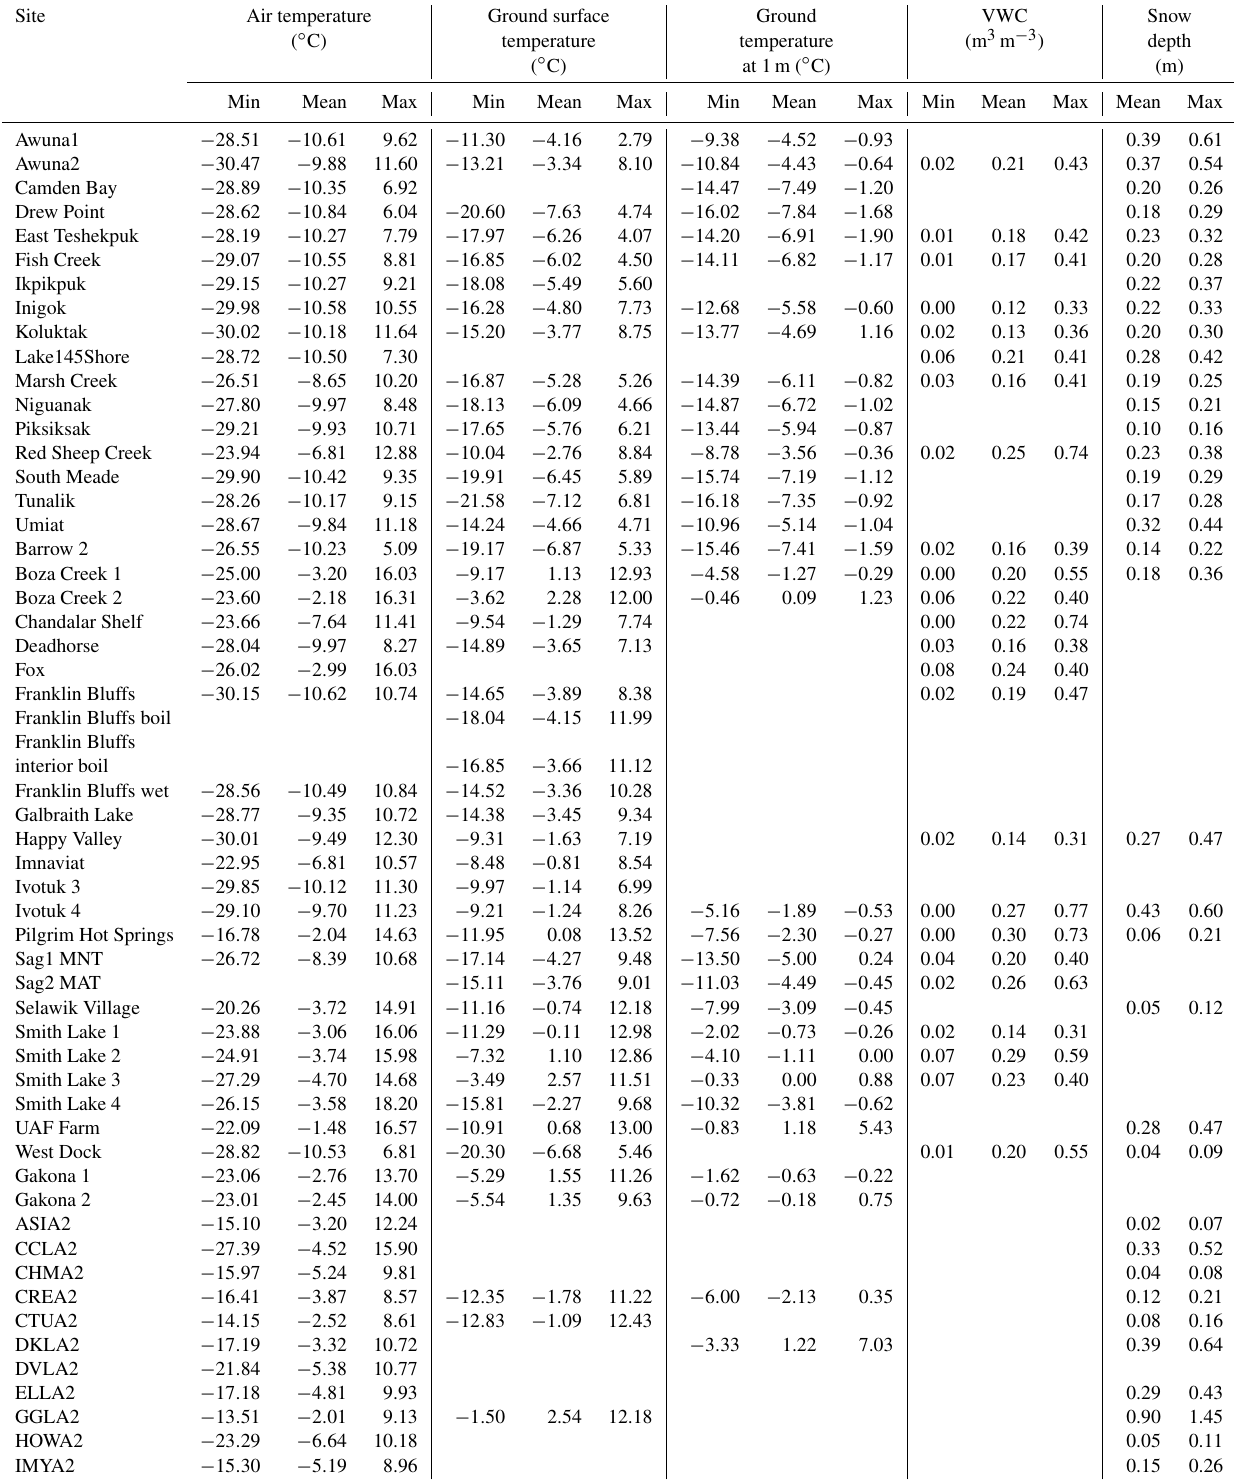
Table 4. Summary of the air, ground surface, ground temperature at 1m, volumetric water content, and snow depth over the entire observation